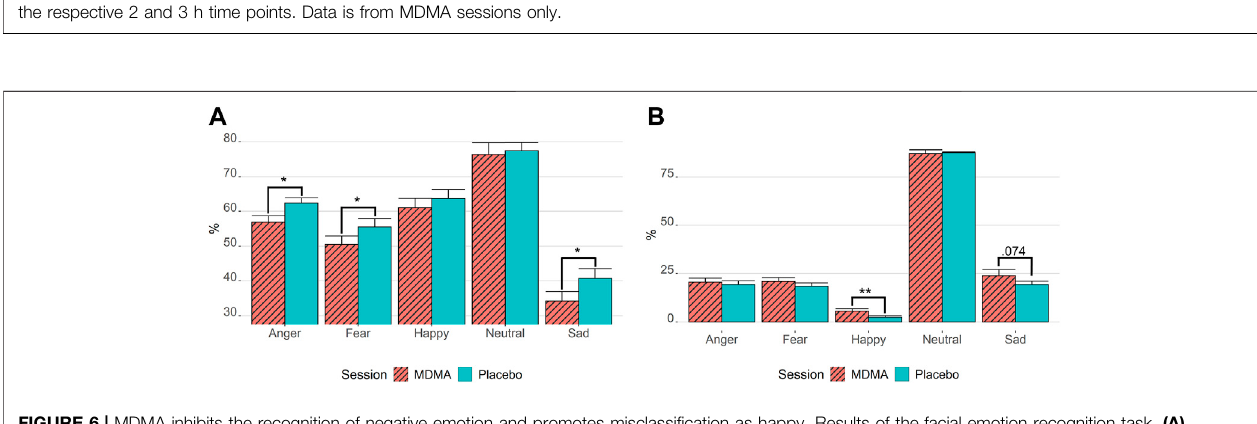
Frontiers in Pharmacology |